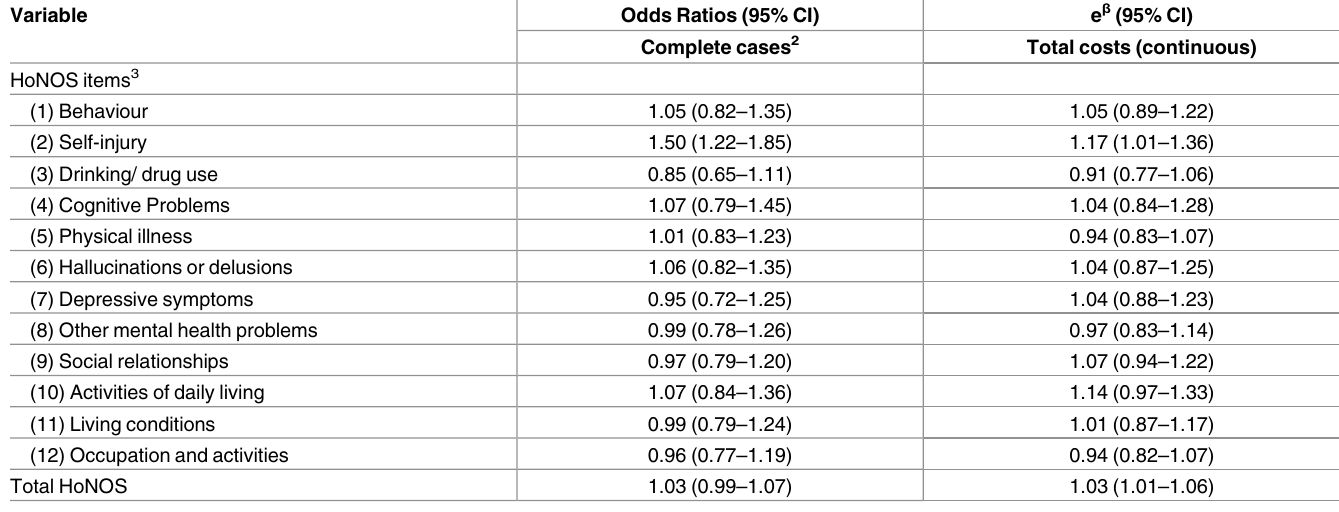
Table 4. Sensitivity analysesfor adjusted models 1 predicting mental health